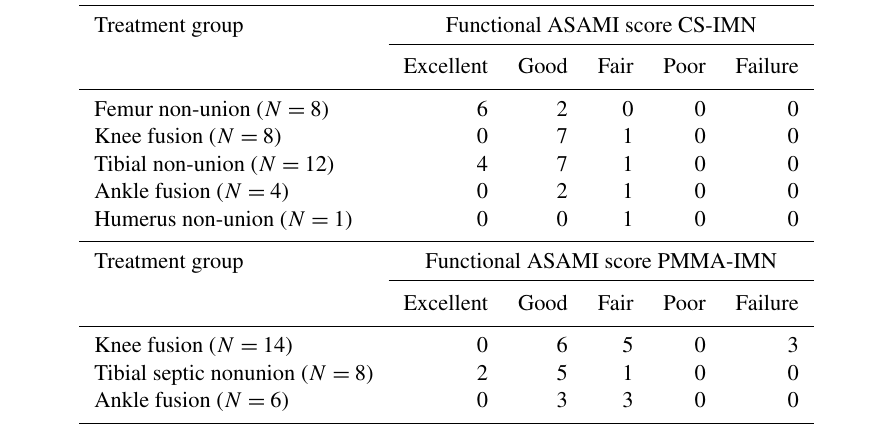
Table 5. Functional ASAMI scores for patients treated for infection prevention and eradication with CS-IMN and for patients treated for infection eradication with